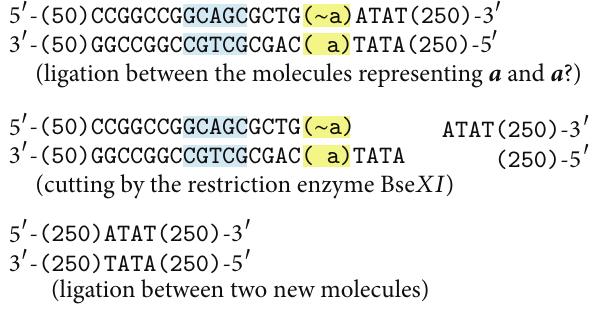
Figure 8: The reaction for a and the question a